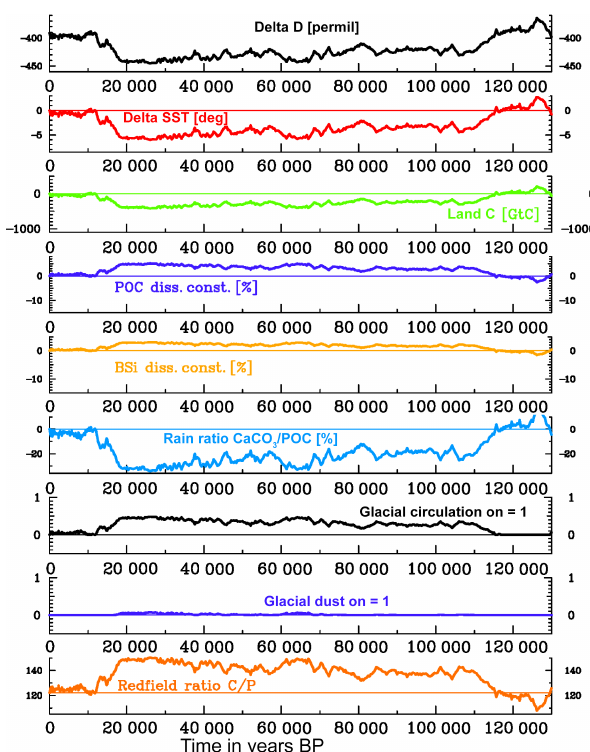
Table 5. Maximum parameter changes at the Last Glacial Maximum relative to the interglacial control run. Run specification SST Land C POC BSi Rain Circulation Dust Carbon ( ◦ ) storage dissol. dissol. ratio change change over- (PgC) rate rate change on on consumption (%) (%) CaCO3:C org (%) (%) change (%) (units C rel. to P) Full rank 8